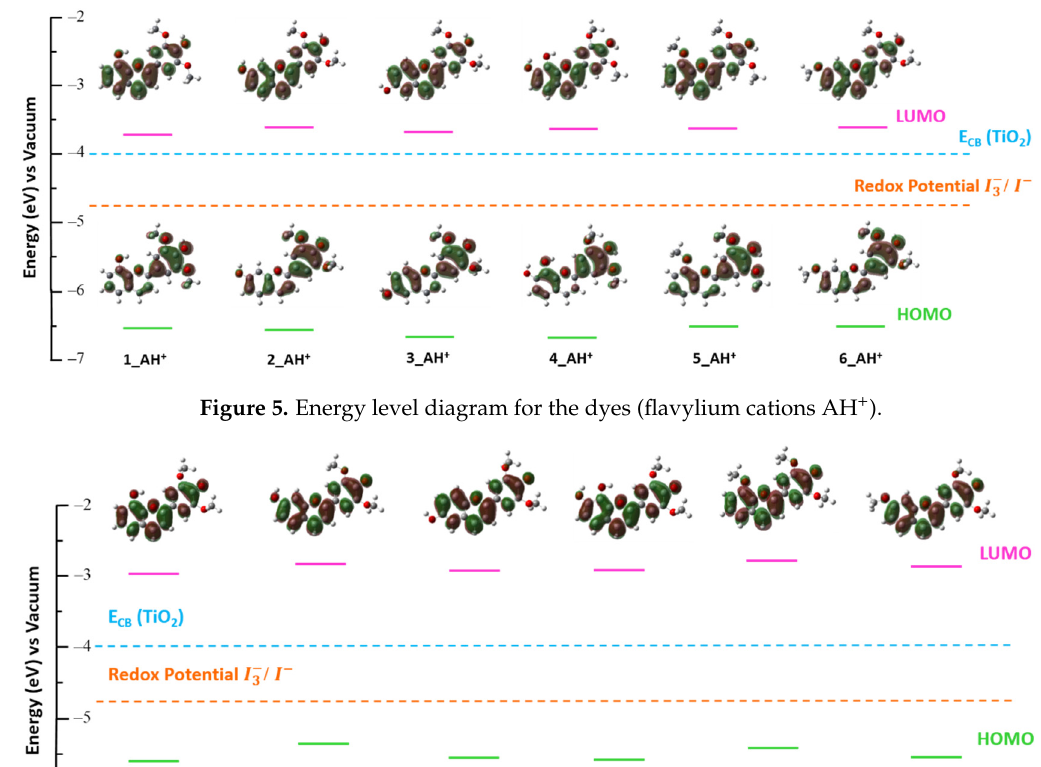
Table 2. The calculated excitation energies, E (eV), the oscillator strength, f, the absorption wave- length, λ (nm), and light-harvesting efficiency, LHE.